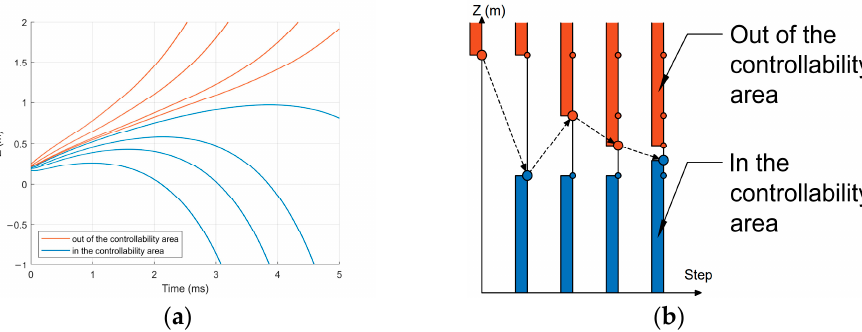
Figure 10. ( a ) Results of the system simulations with different initial vertical plasma displacements and maximum voltages on the HFC. ( b ) Principle of the binary search algorithm to find the control- lability region. Red points are initial displacements out of the controllability region and blue points are inside the controllability region. Step by step, the limit of the controllability region estimation accuracy grows. The accuracy increases up two times at each step.